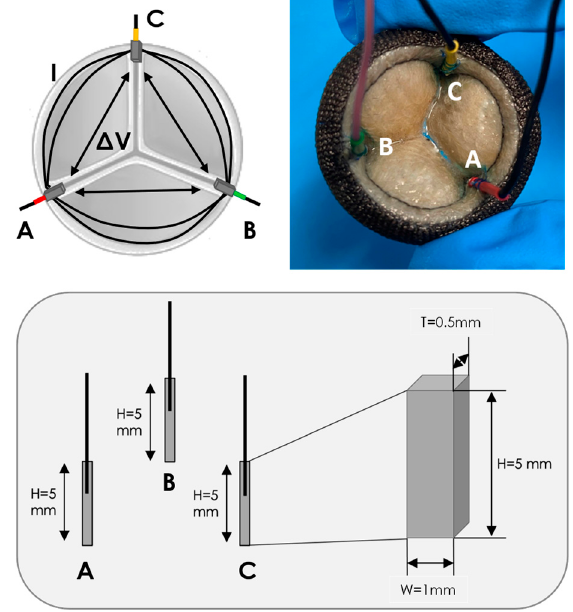
Figure 1. Small parallelepiped-shaped electrodes (A, B, C) embedded in the commissures of the BHV.